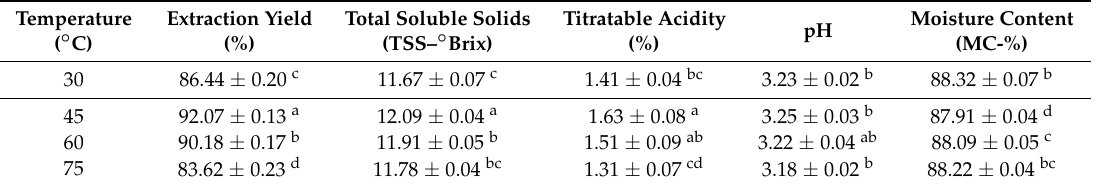
Table 4. Juice yield, TSS, and TA (mean ± SD) of mulberry juice at different ultrasonic temperatures.